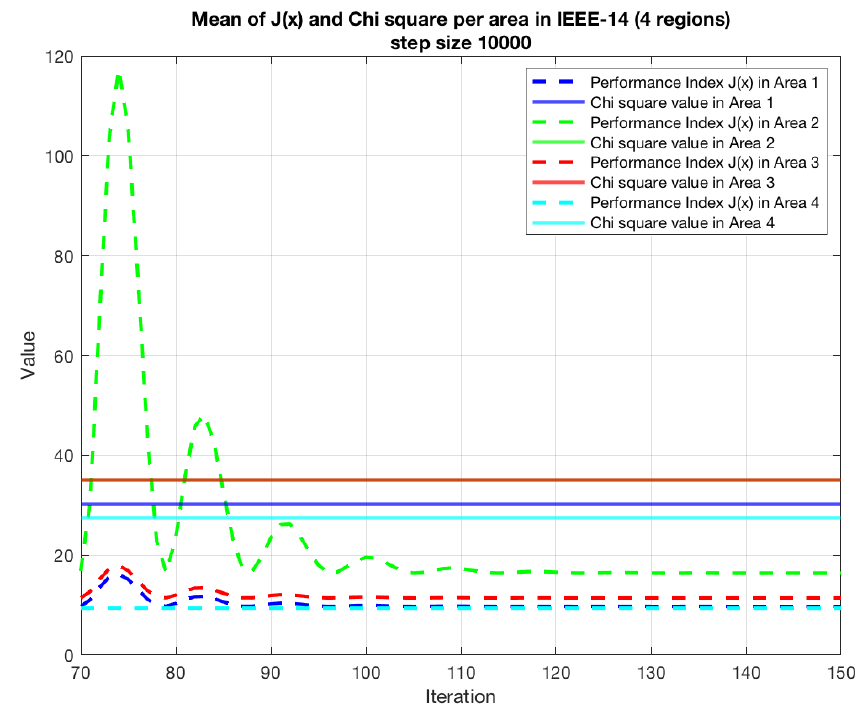
Figure 5. Per area mean of J(x) on the IEEE -14 bus system 4 regions.